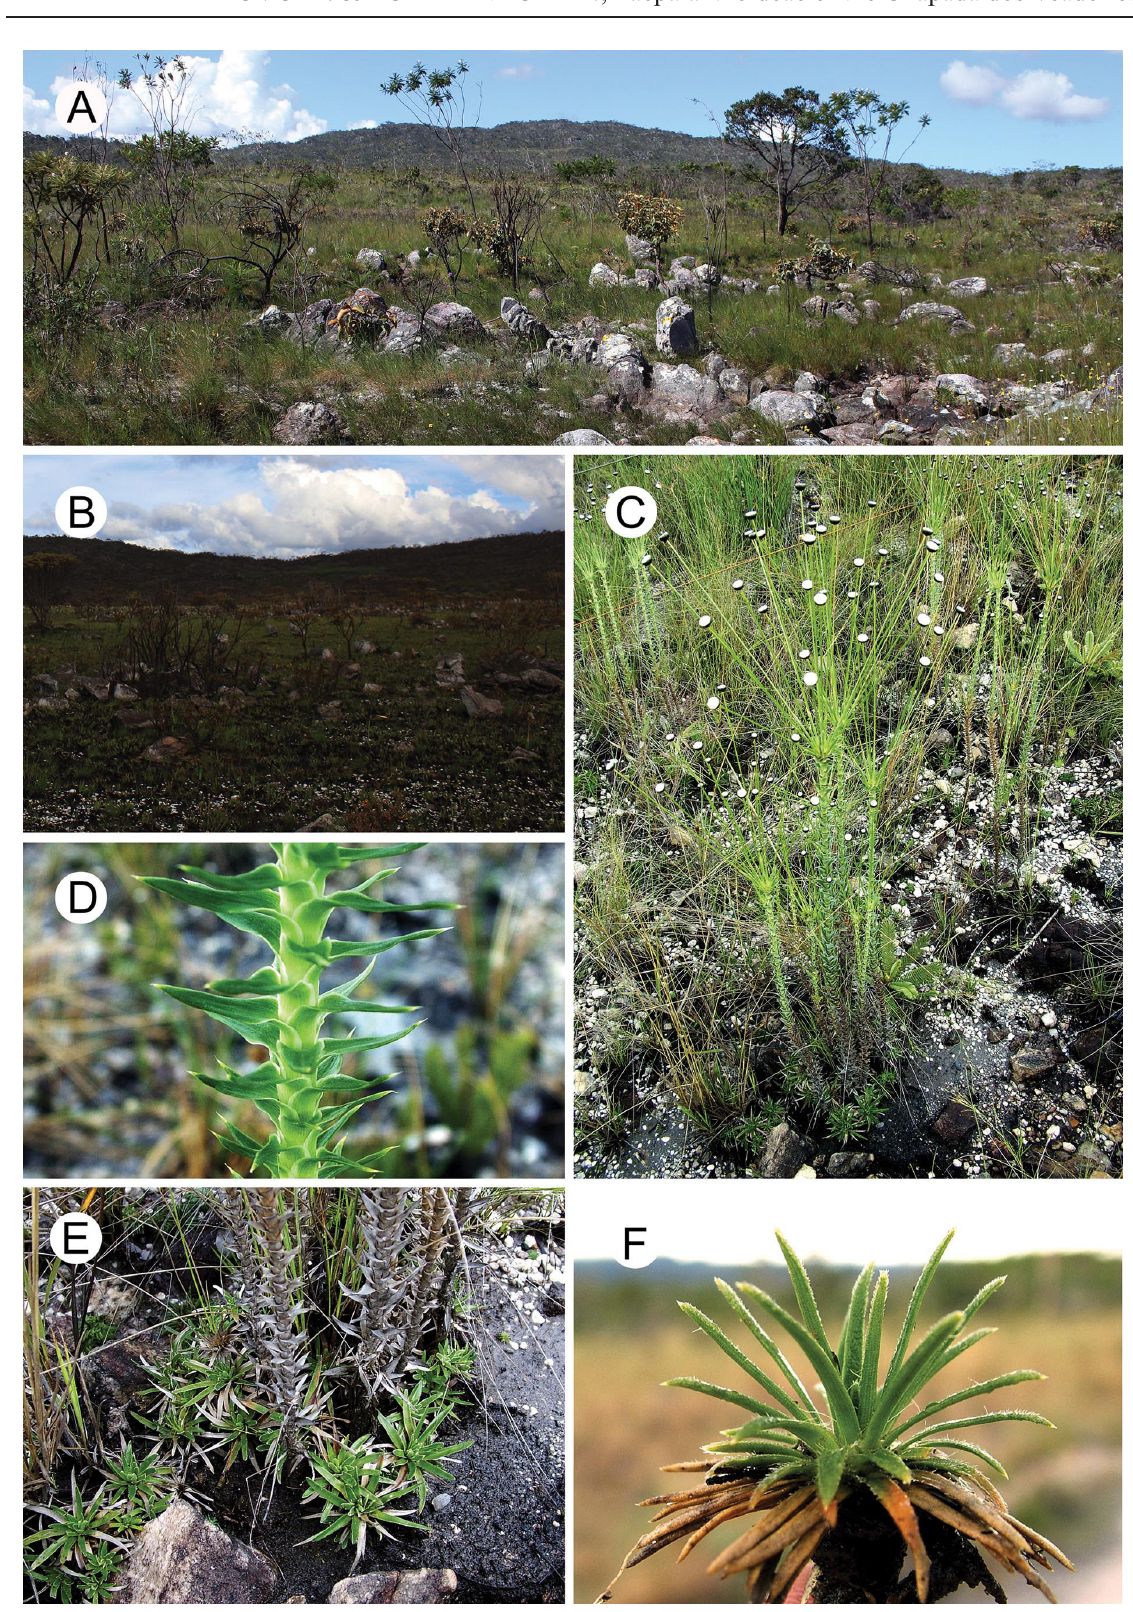
Fig. 5. Paepalanthus irwinii Trovó & Echtern. sp. nov. A . Habitat. B . Habitat detail. C . Habit. D . Reproductive axis detail. E . Sprouting rosettes. F . Rosette